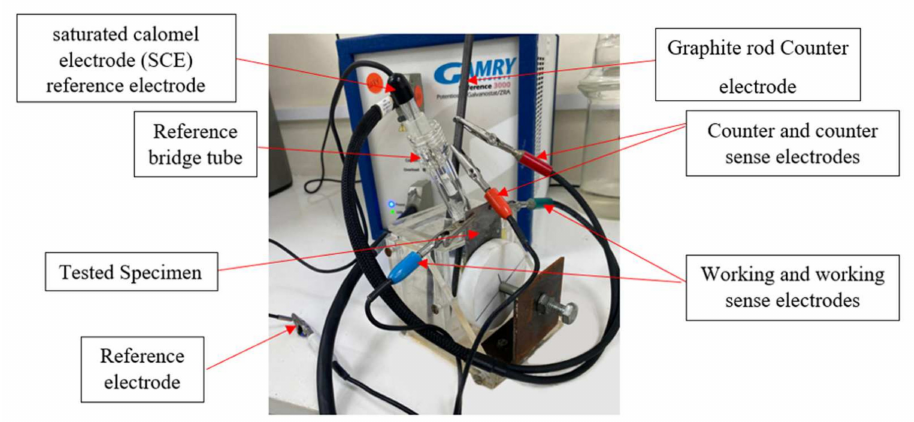
Figure 3. The electrochemical cell